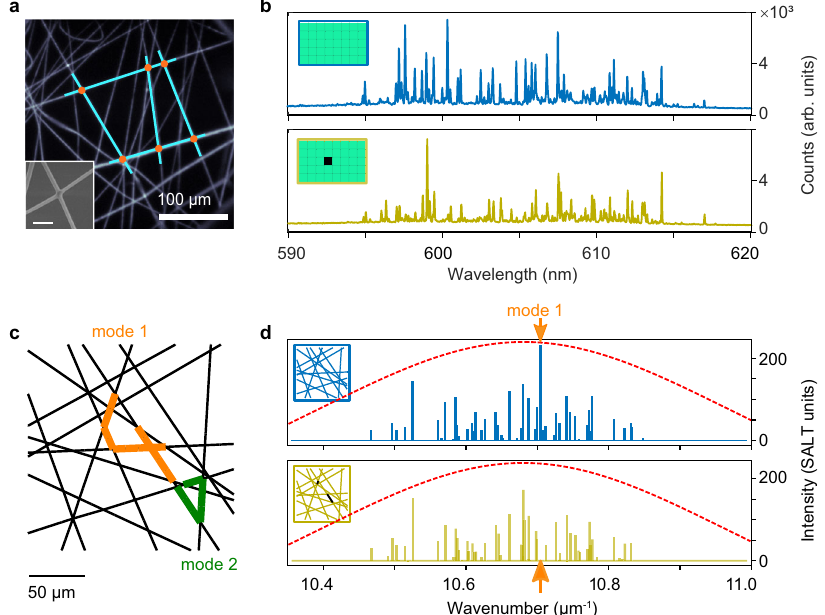
Fig. 1 | Spectral sensitivity of network lasers to pump pro fi le. a Fluorescence image of a photonic network with interconnected dye-doped polymer nano fi bers. Asaguidetotheeye,wehighlightthegraphtopology(edgesasbluelines,nodesas orange dots) over a few links as an example. Inset: scanning electron microscopy image of a node of the network formed by annealing two nano fi bers (scale bar= 1 μ m). The nano fi bers have diameters in the range 200 – 500nm and function as single-mode waveguides for light emitted by the dye. b Lasing spectrum of the networkin a obtainedwithuniformillumination(blue)andwithaslightlymodi fi ed pumppattern(yellow),bothatpump fl uenceof1.5mJcm − 2 pulse − 1 .Theinsetsshow the respective pump patterns; the illumination area on sample is 300×480 μ m 2 and the modi fi ed pattern has pump removed from a small area 60×60 μ m 2 in the